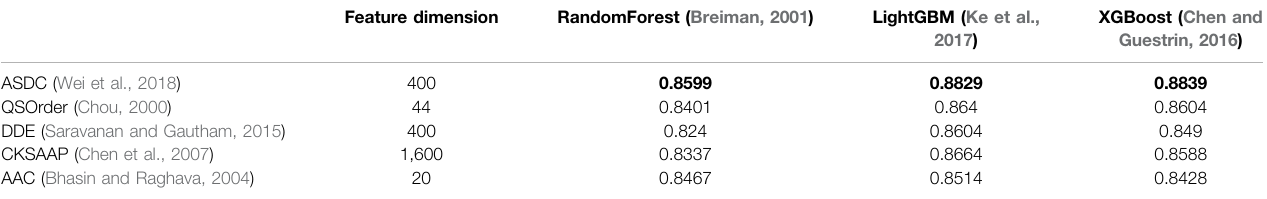
TABLE 1 | Feature dimensions of partial feature extraction algorithms and AUROC performance under multiple classi fi